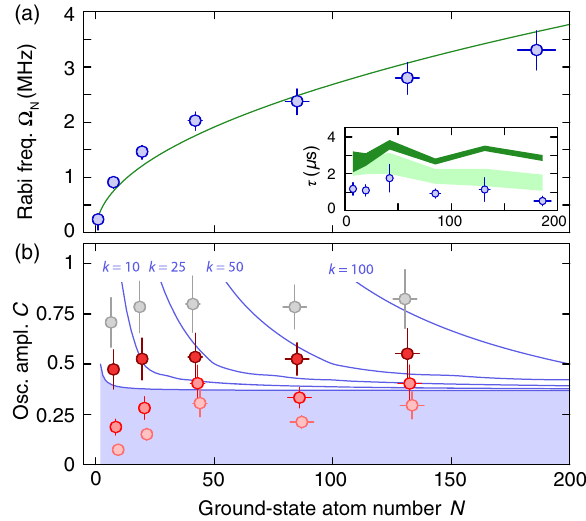
FIG. 3. Scaling of the Rabi frequency and entanglement. (a) Extracted values of Ω (blue points) versus average initial N atom number N for the data shown in Figs. 1(d) and 2 with a power-law fit (green line). The inset shows the exponential decay time of the Rabi oscillations (blue points). The expected decay based on the reference sample atom-number fluctuations (dark green shading) and additionally taking into account noise in the pulse area (light green shading) are shown for comparison. (b) Extracted oscillation amplitude C of the collective Rabi oscillation versus atom number N after one, three, and five half cycles of oscillation (red data points with increasing lightness, shifted slightly horizontally for better visibility). The gray points show the oscillation amplitude after one half cycle corrected for the measured detection efficiency. The blue shaded area bounded by the lowest blue line includes all classical states with fully separable density matrices. Different bounds for k -particle separability are additionally shown by the blue lines. Error bars in (a) take experimental day-to-day variations of the single-atom Rabi frequency Ω (10%) and the detuning ( (cid:2) 200 kHz) into account. All error bars in (b) are 1 σ statistical uncertainty from the